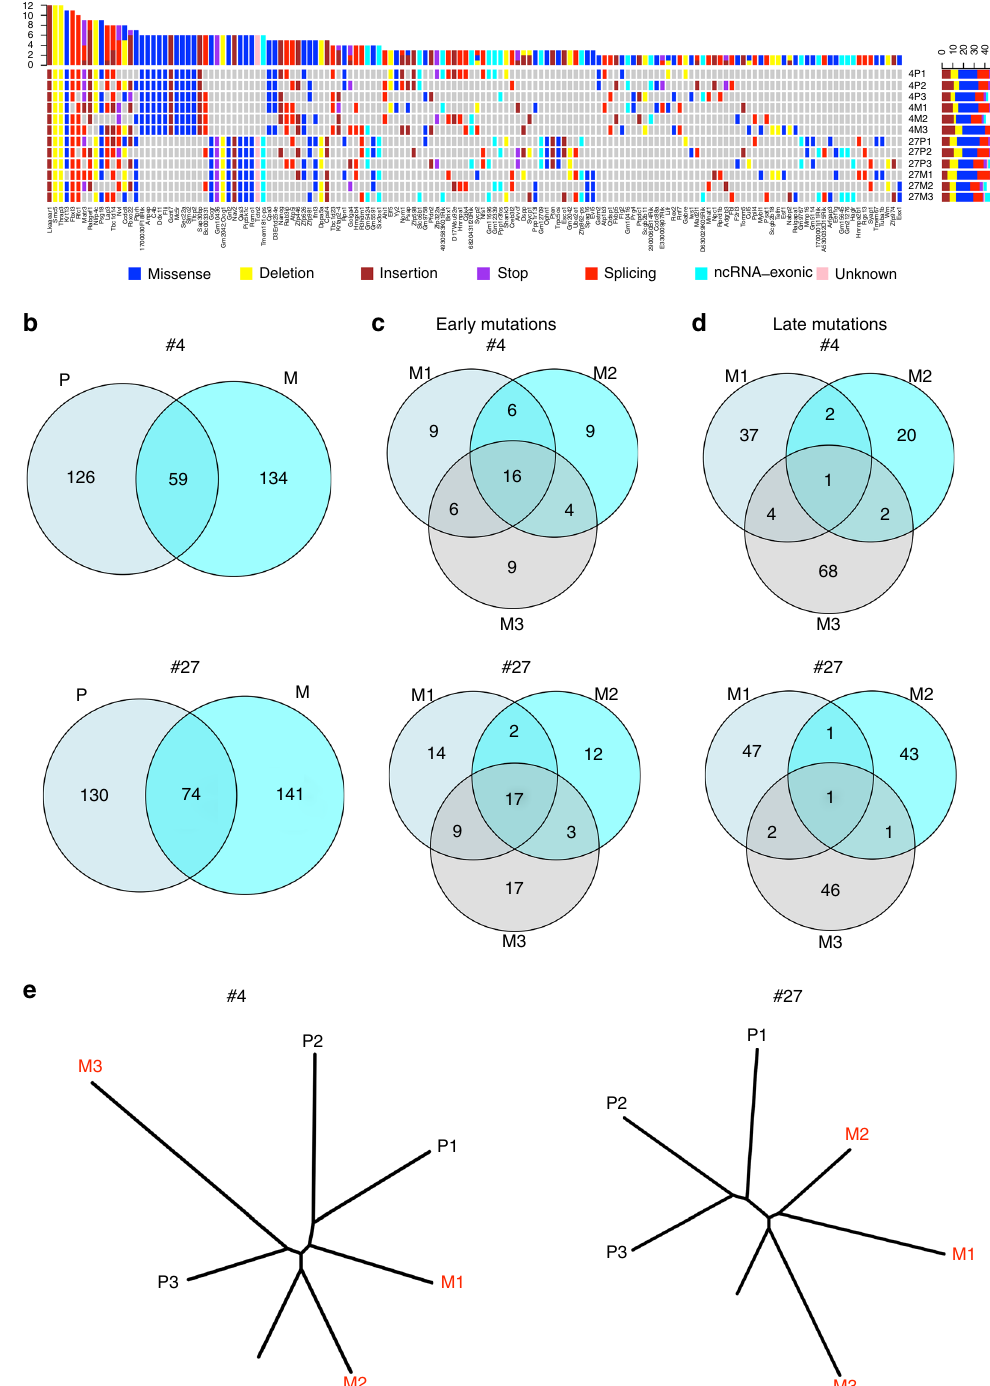
Fig. 4 Genomic heterogeneity and mutational evolution in mammary tumors driven by somatic Trp53R245W mutant. a Heatmaps of genes with various alterations identi fi ed in at least two tumors or metastases of the three physically separated regions of primary tumors (P1 – P3) and associated metastatic clones (M1 – M3) from each of two Trp53 wm-R245W/ + mice (#4 and #27), subjected to high dose Ad-Cre intraductal injection. Note that some genes have more than one alterations. b Venn diagrams depicting the overlap of the identi fi ed mutations in primary tumors (P) with those in the associated metastases (M) in mouse #4 and #27. c Venn diagrams depicting the overlap of the identi fi ed early mutations among all three metastatic clones (M1 – M3) in mouse #4 and #27, respectively. d Venn diagrams depicting the overlap of the identi fi ed late mutations among all three metastatic clones (M1 – M3) in mouse #4 and #27, respectively. e Phylogenetic trees generated by clustering genome-wide mutation data from 3 multi-region primary tumor samples (P1 – P3) and 3 metastatic clones (M1 – M3) for both mouse #4 and #27. Relative branch lengths were determined from the proportion of mutations in each